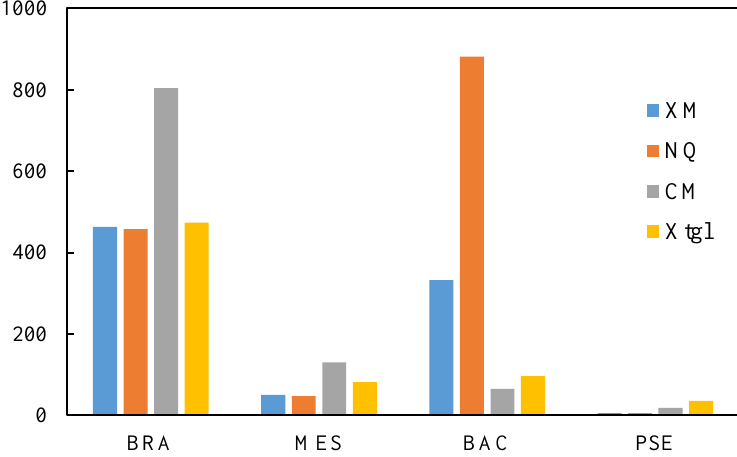
Figure 4. Distribution of plant growth-promoting rhizobacteria at di ff erent sites, BRA is Bradyrhizobium , MES is Mesorhizobium , BAC is Bacillus , and PSE is Pseudomonas